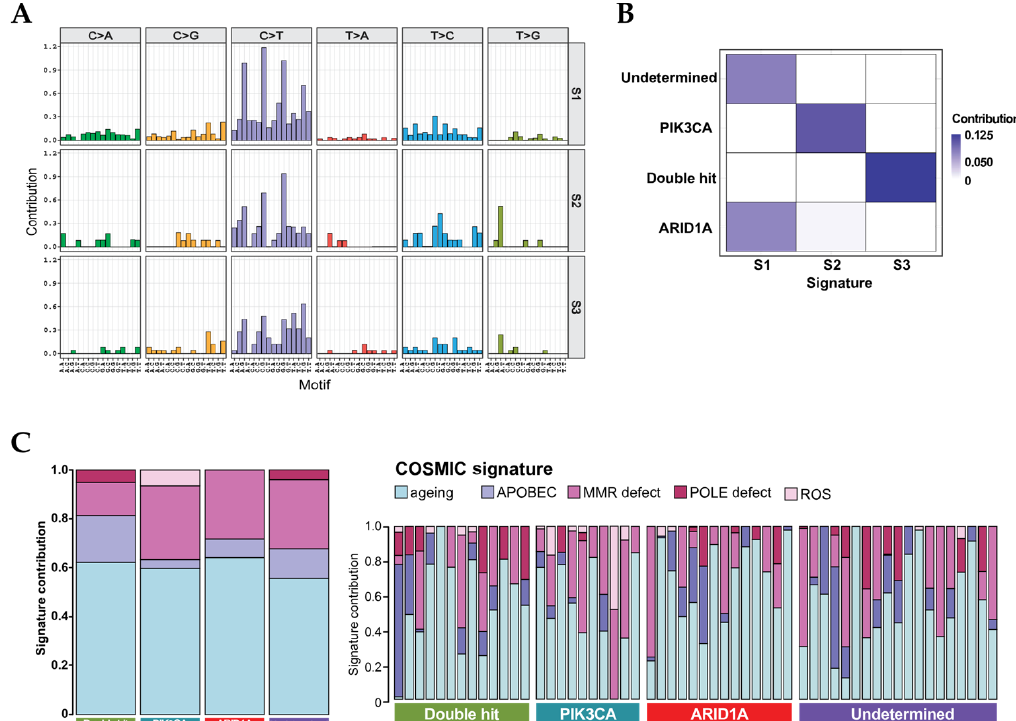
Figure 3. Patients show distinct mutational signatures within OCCC. ( A ) De novo assessment of mutational landscape indicated that OCCC patients presented 3 different signatures, signature1, signature2, and signature3. The sub-groups “Double hit” and ”PIK3CA” showed unique signatures, signature2 and signature3, respectively. Whereas “ARID1A” and “Undetermined” sub-groups shared the same signature, signature1 ( B ). ( C ) COSMIC supervised signatures within the 4 sub-groups, confirming the differences among them. The highest relevant of signatures were from ageing, APOBEC, MMR defect, POLE defect, and ROS. Mutation co-occurrence and pathways dysregulation in